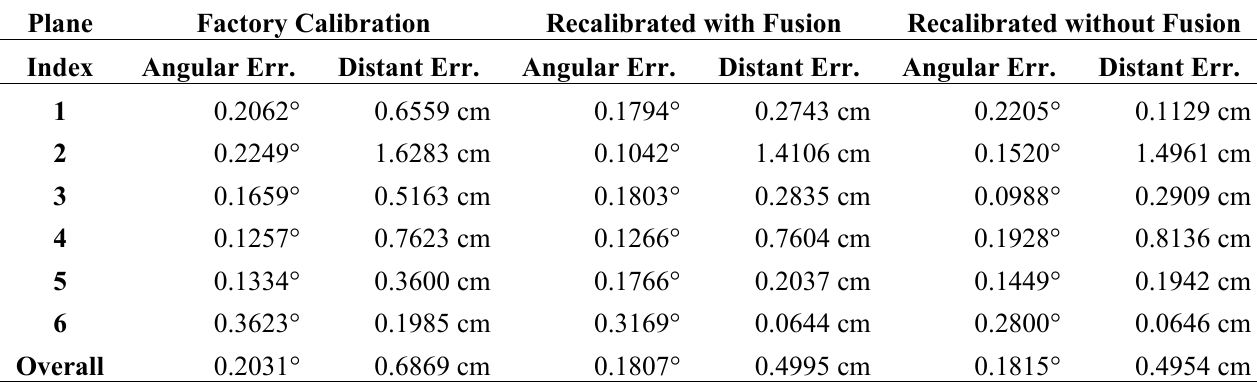
Table 5. Angular and distance plane misalignment with and without data fusion.